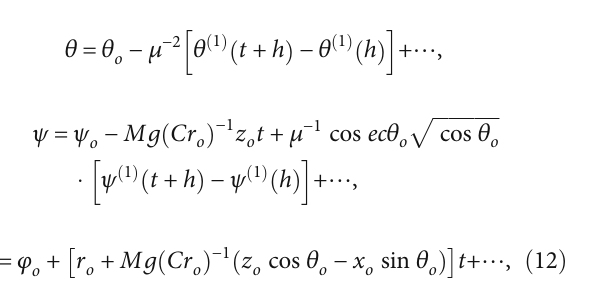
Figure 9: The stability of the analytical and numerical solutions _ x